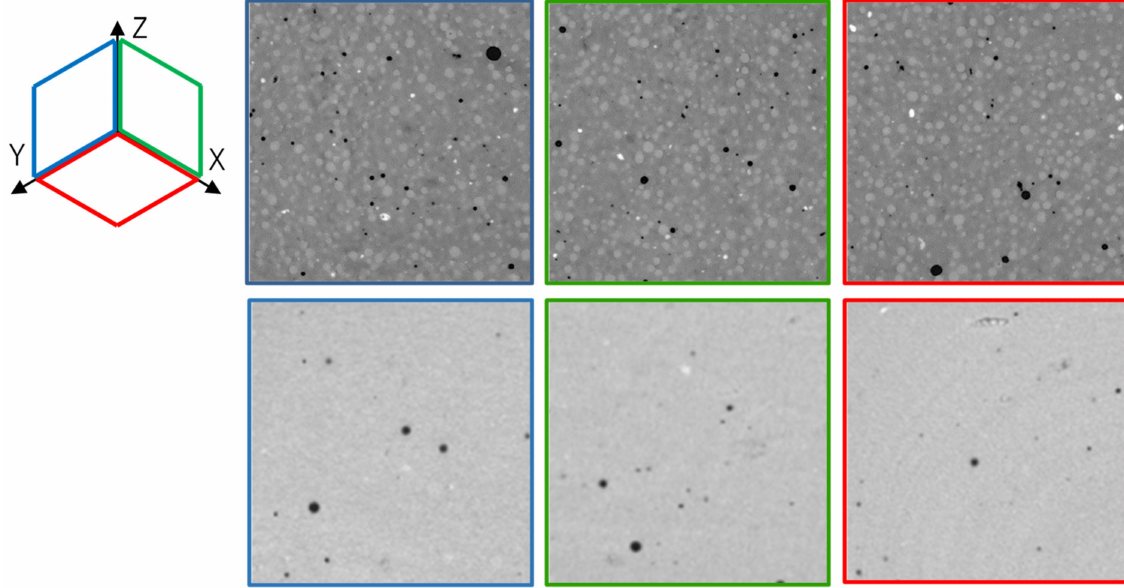
Figure 3. Tomography images: MS_1_SF_T50_21d ( top ) and MS_1_Cs_T20_3d ( bottom